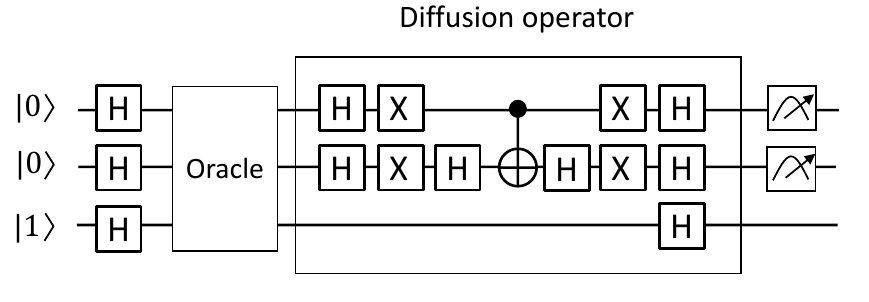
Figure 8. Grover search algorithm.